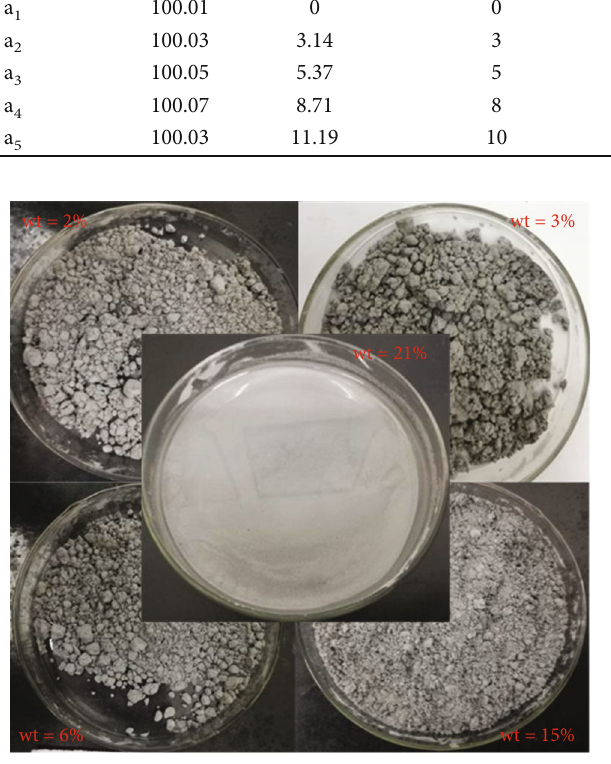
Figure 3: Photos of representative aluminum powder samples with di ff erent moisture